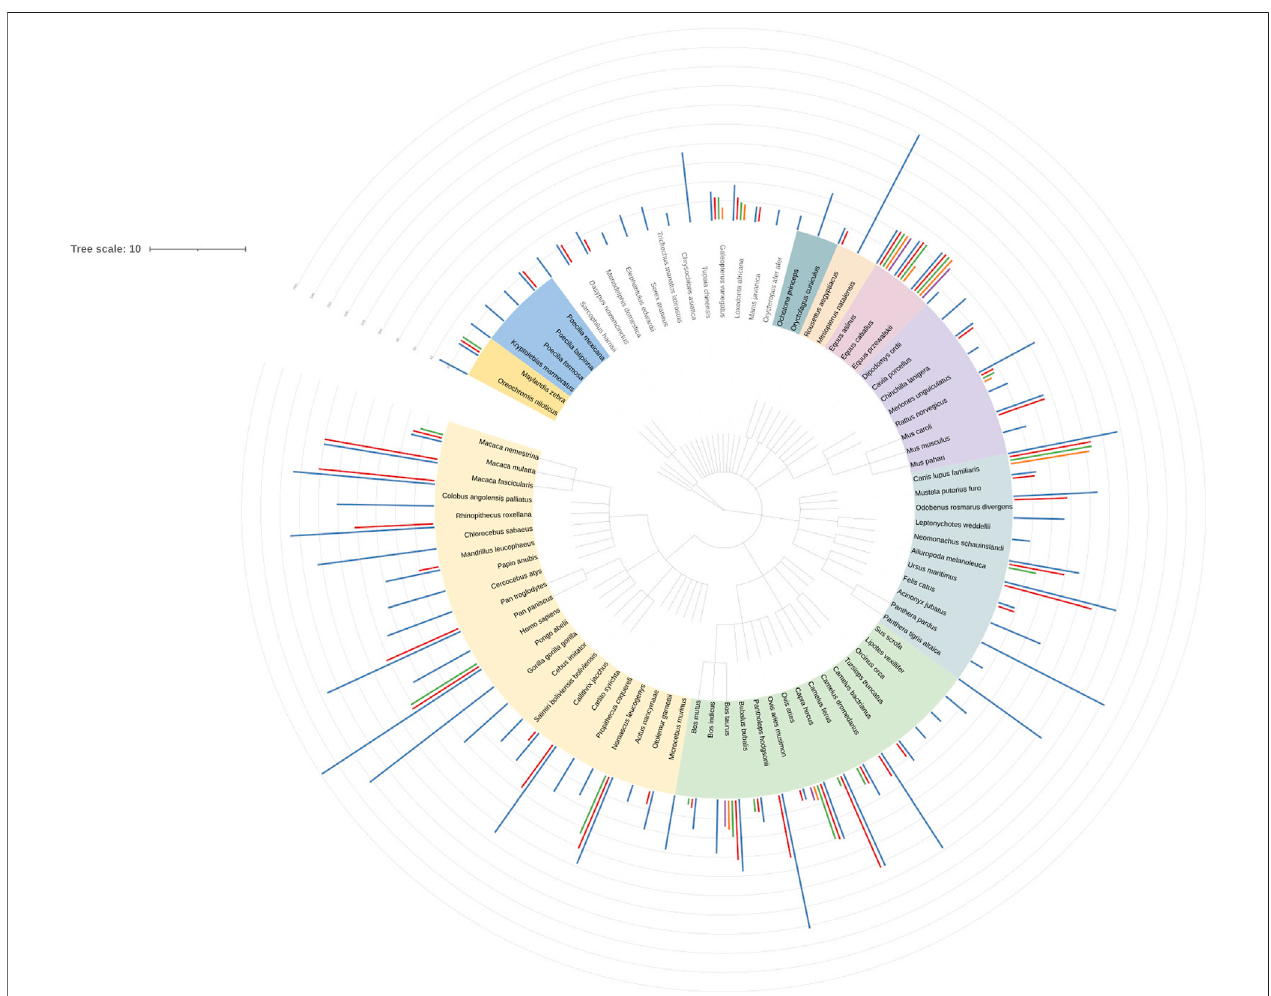
FIGURE4 | Nickel cleavage sites dataset visualization iniTOL (Letunic and Bork, 2021). Nucleic Acids Resdoi: 10.1093/nar/gkab301. Dataset from supplemental table 18 has been used to create a tree in CommonTree (https://www.ncbi.nlm.nih.gov/Taxonomy/CommonTree/wwwcmt.cgi) and visualized in iTOL. Species colours describe taxonomic orders. Data from the ScanProsite analysis of cleavage motifs has been used to create bars outside the tree. Their height indicate the number of cleavage sites.